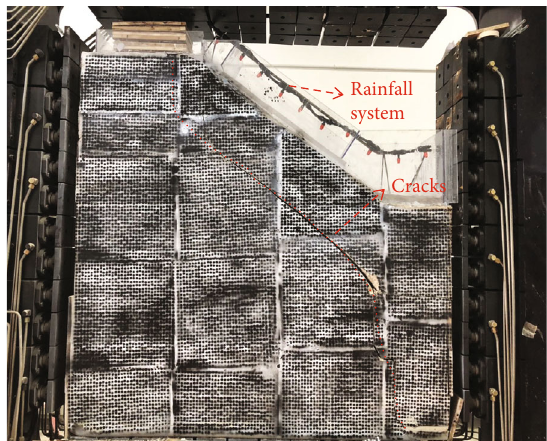
Figure 23: Slope model after the